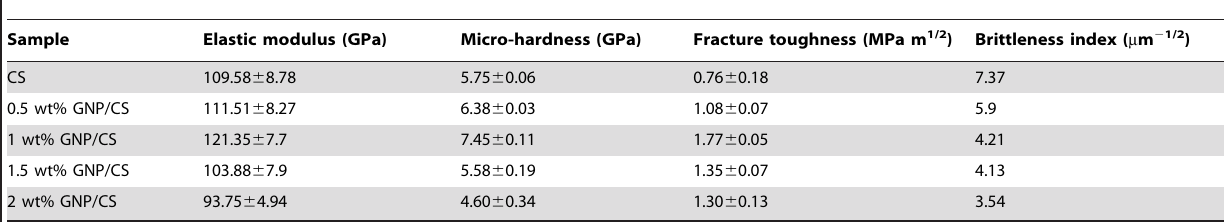
Table 2. Mechanical properties of pure CS and GNP/CS composites.